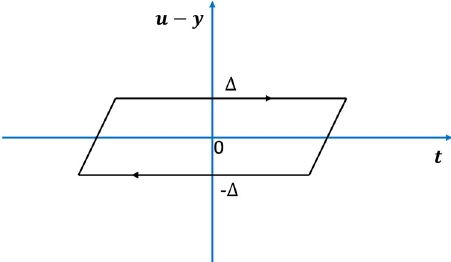
FIG. 3. Time-varying displacement offset u − y over a period of